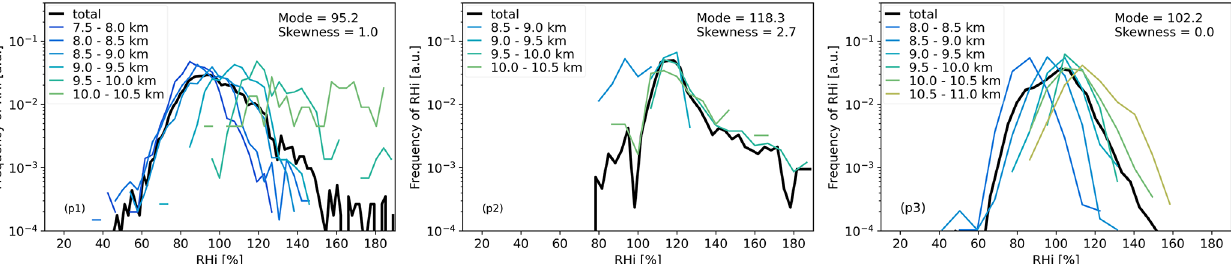
Figure 7. PDF of in-cloud RHi in vertical layers with 500m depths from the cloud bottom to the cloud top. From left to right: (p1) young cells, (p2) mature cell and (p3) stable cell, in accordance with Fig. 6. The number of layers differs depending on the geometrical depth of the cloud and the depth at which the lidar could provide